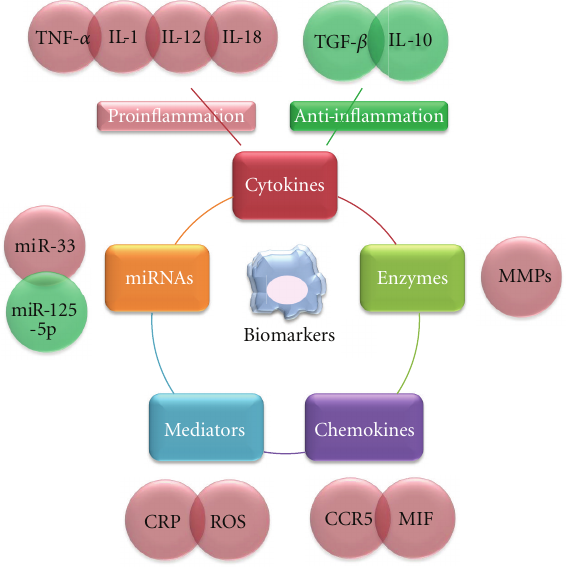
Figure 5: Pro- and anti-inflammatory biomarkers and microRNAs related to macrophages. All of these inflammatory markers and mediators, released at di ff erent stages of progression in atheroscle- rosis, can enter the circulation, a ff ecting the prognosis of patients with